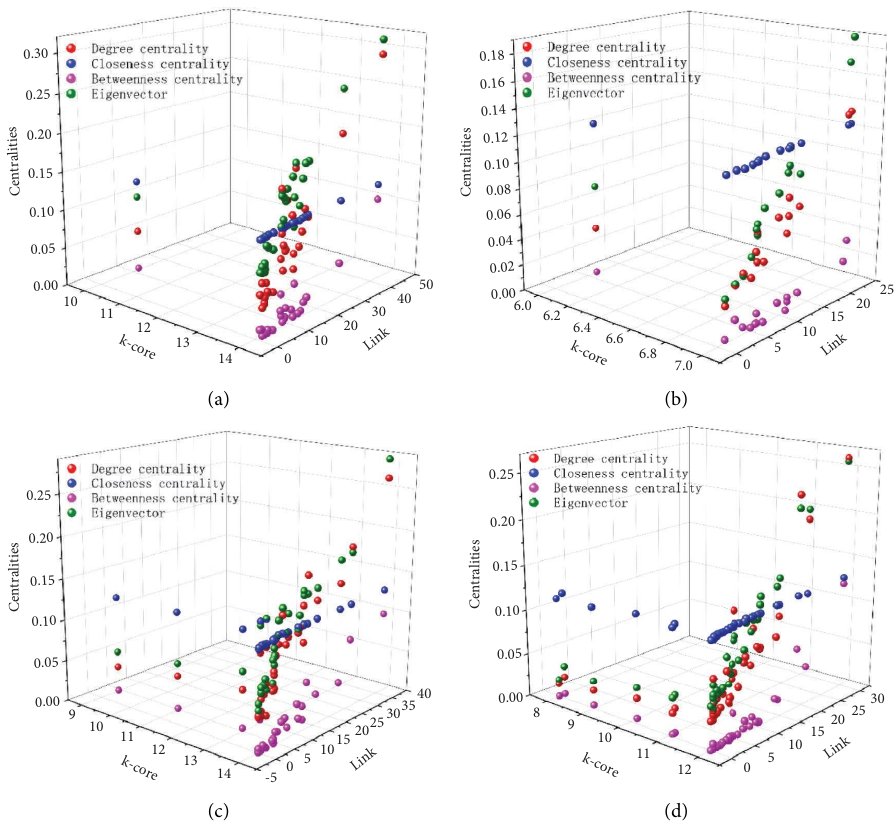
Figure 8: Correlation analysis of key nodes in the communities: (a) correlation analysis of West Asia and North Africa community, (b) correlation analysis of Russian community, (c) correlation analysis of Central and Eastern European Community, and (d) correlation analysis of China and Southeast Asian